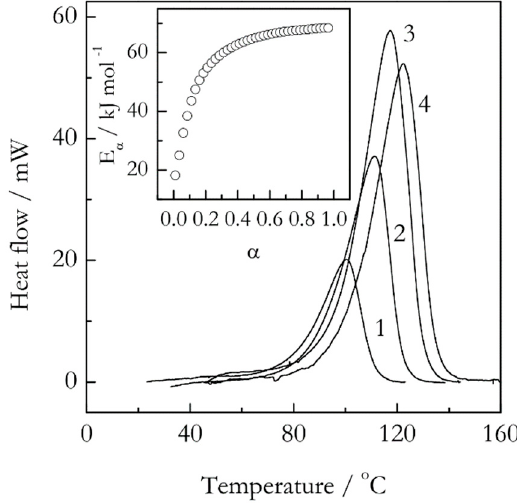
Figure 3. DSC curves for crosslinking polymerization of an epoxy-anhydride system. The numbers by the curves are heating rates in °C min − 1 . The inset shows the conversion dependence of the isoconversional activation energy. Adapted with permission from Vyazovkin and Sbirrazzuoli [29]. Copyright 1999 Wiley-VCH.